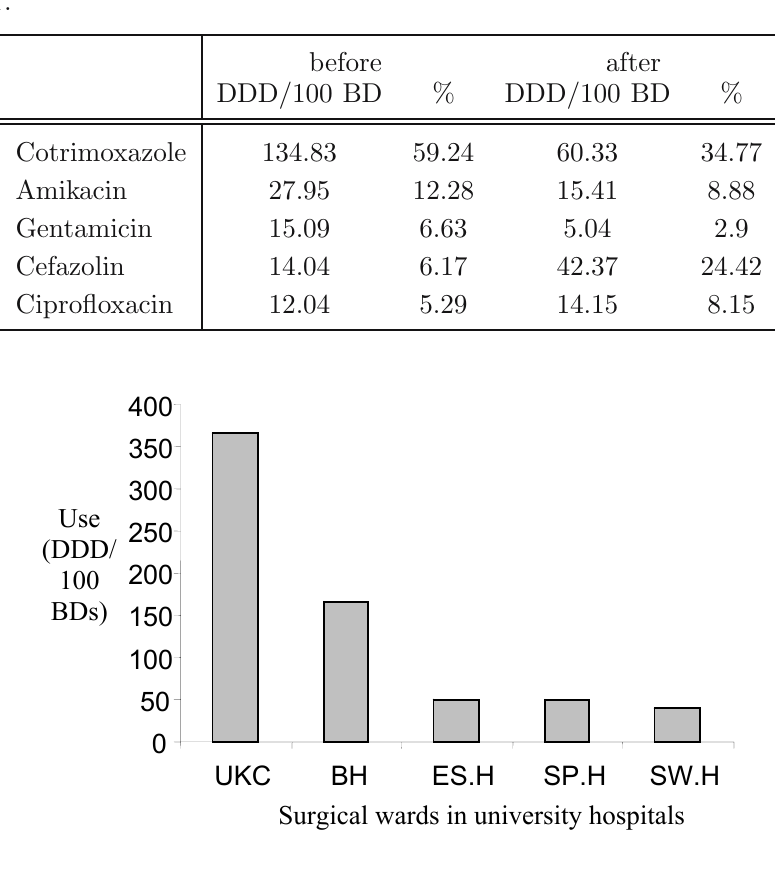
Fig. 1 Use of systemic antibacterial agents in surgical wards of the University Clinical Center, Nis (UKC) compared with four other university hospitals. Data for the four other hospitals were obtained from previously published reports [15, 22]. BH, Bouali hospital, Iran; ES.H, hospital in Estonia; SP.H, hospital in Spain; SW.H, hospital in Sweden. At the urology ward, systemic antiinfectives (group J) were the most utilized group of drugs with 263.54 DDD/100 BDs or 43.05% of overall drug use. Following implementa- tion of the unit-dose drug distribution system, antimicrobial use fell to 191.63 DDD/100 BDs or 41.37%. This difference in antimicrobial use was statistically significant (p < 0.05). Considering the low risk of serious infection after urologic surgery, antimicrobial prophy- laxis should be considered only in patients at high risk of postoperative bacteriuria (i.e., patients likely to require prolonged postoperative catheterization and patients with a pos- itive urine culture) or in hospitals with infection rates of greater than 20% [22].